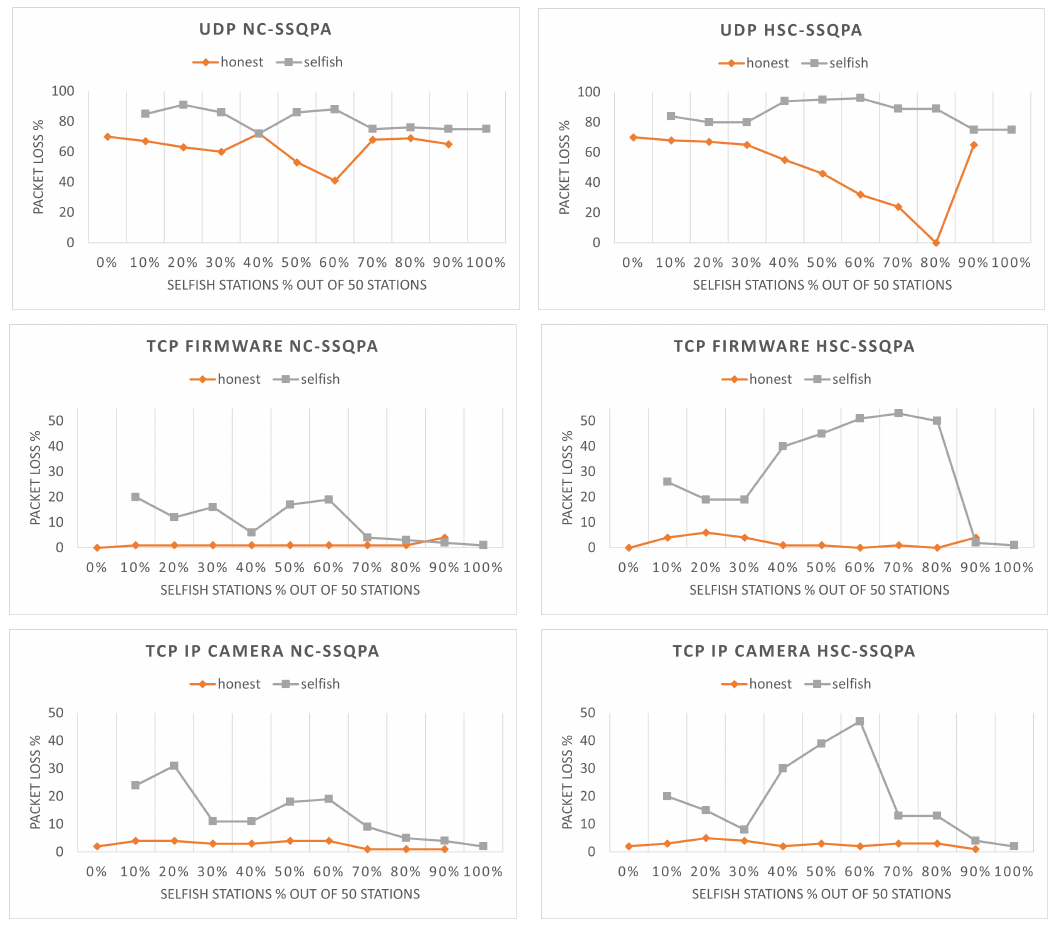
Figure 14. Packet loss comparison of selfish and honest stations in both variants of SSQPA: ( left ) NC- SSQPA, ( right )